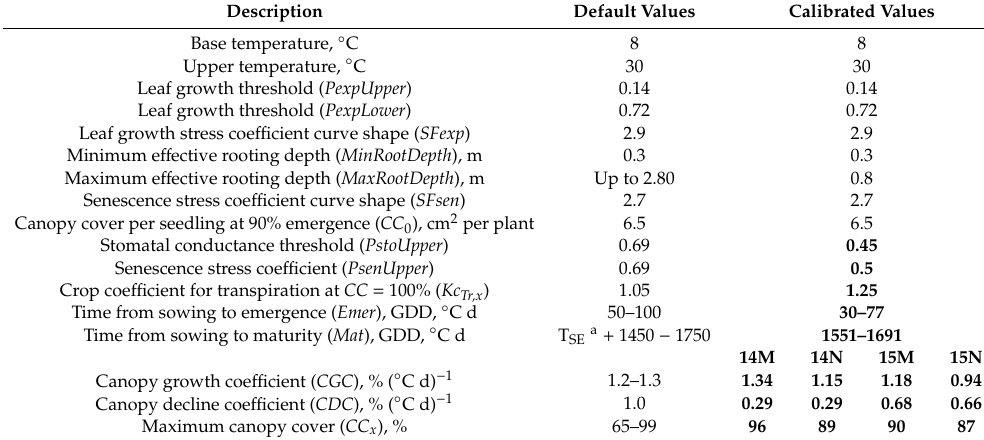
Table 2. Default and calibrated values of parameters of seed maize in the AquaCrop